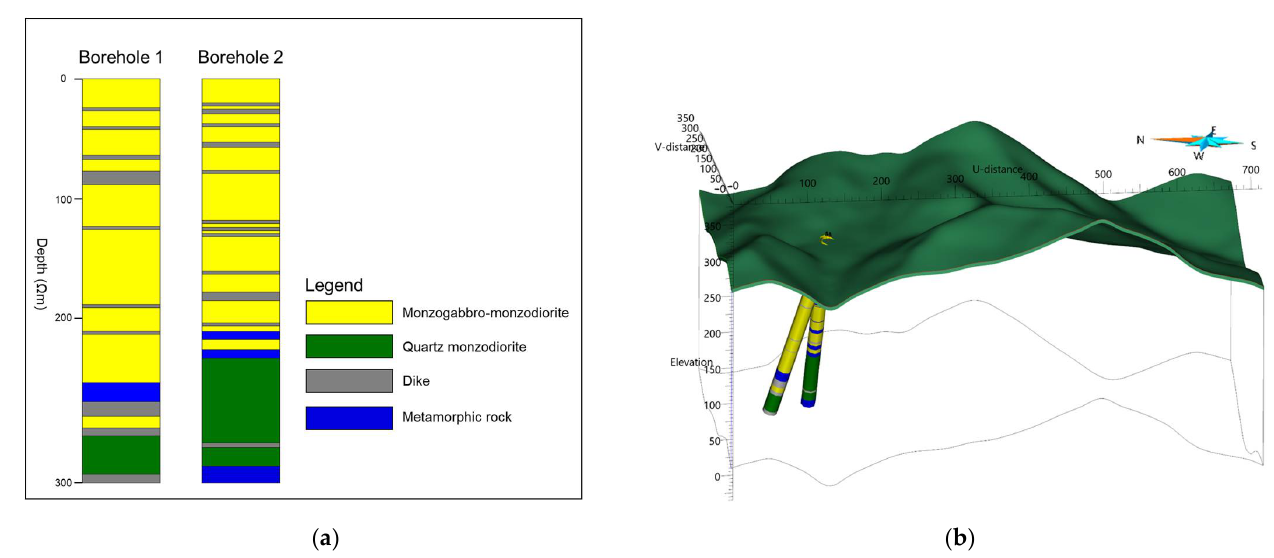
(d) Figure 6. Pseudo-sections of survey line 1 of ( a , c ) observed and ( b , d ) predicted data obtained from ( a , b ) two- and ( c , d ) three-dimensional inversion. 4. Discussion To interpret the interior of the 3D electrical resistivity inversion results, we used the drilling data obtained by KIGAM in 2019 [17]. A total of 4 drilling up to 300 m depth were